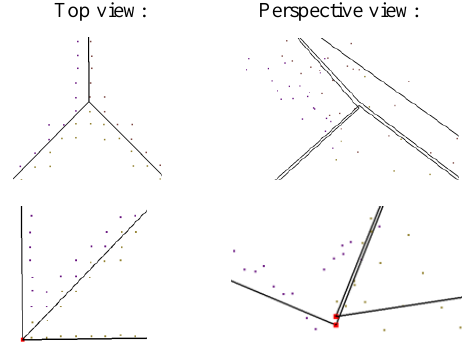
Figure 1. Two examples of unintentional gaps between roof planes after applying the MDL based optimization method presented in (Sohn et al., 2012).